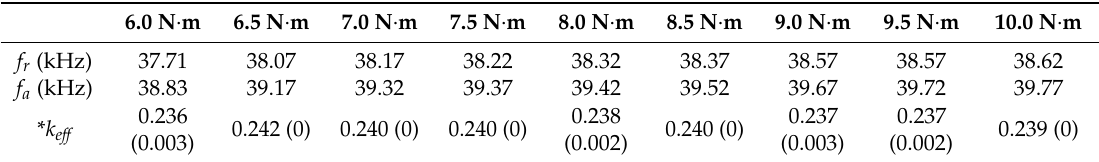
Table 3. Measurement results under pre-loading